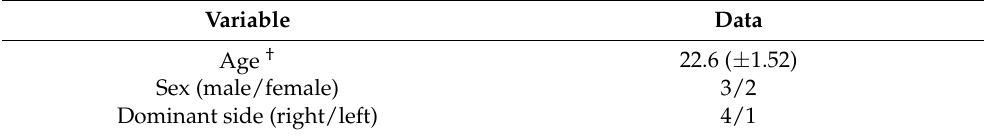
Table 1. Demographic data of